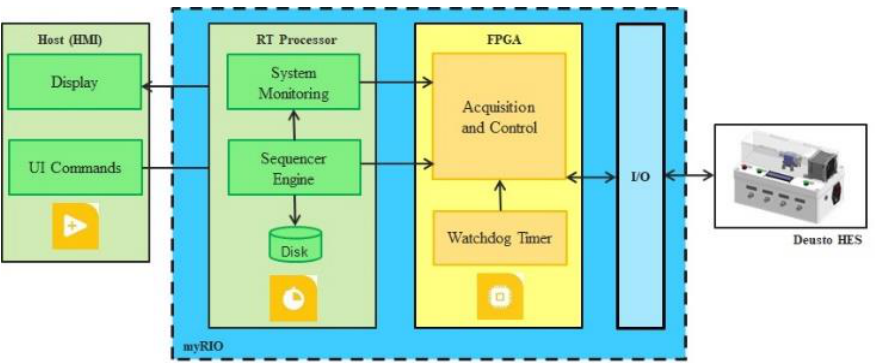
Figure 24. Scheme of the hardware architecture used for operation and implementation of control algorithms applied to the